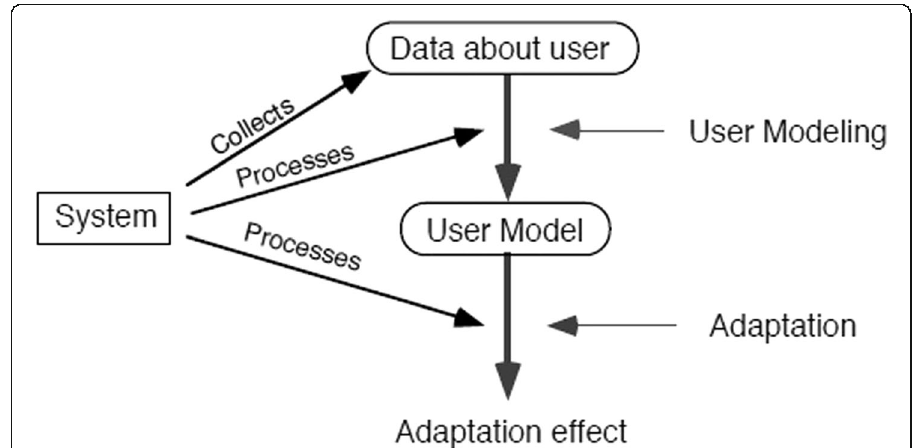
Fig. 1 “ User modeling – adaptation ” loop in adaptive systems, (Brusilovsky,